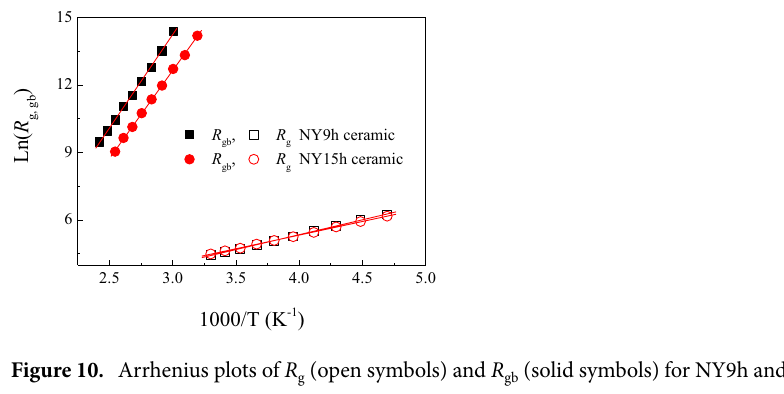
Figure 10. Arrhenius plots of R g (open symbols) and R gb (solid symbols) for NY9h and NY15h